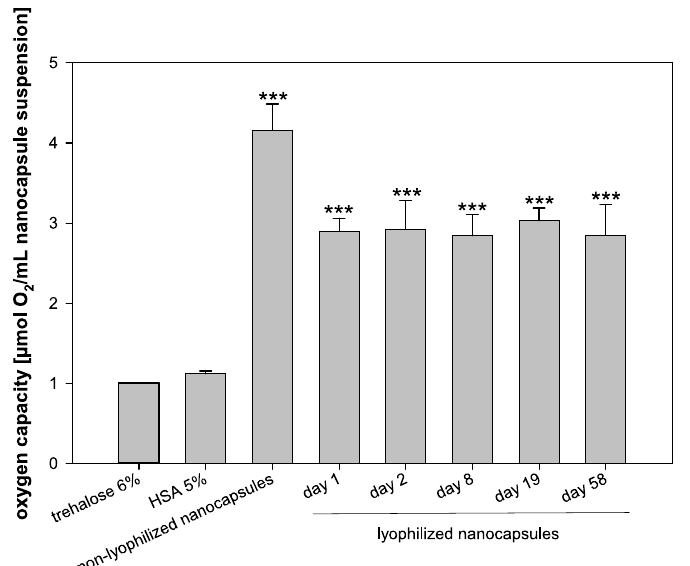
Figure 7. Oxygen capacity of trehalose 6%, HSA 5%, non-lyophilized nanocapsules on day 0, and lyophilized nanocapsules on days 1, 2, 8, 19, and 58, respectively (statistical test: one-way ANOVA; *** for p ≤ 0.001 compared to controls; mean ± SD; n = 3).